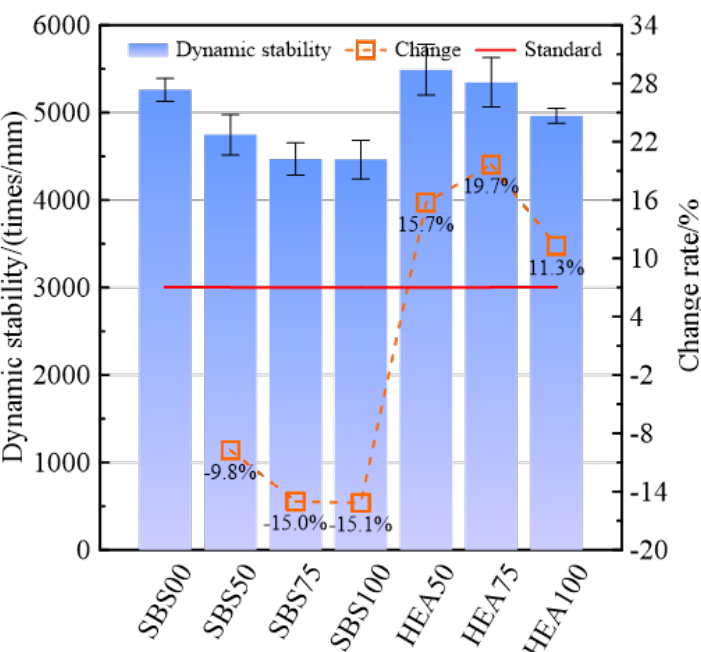
Figure 3. High-temperature stability performance of salt-storage asphalt wear